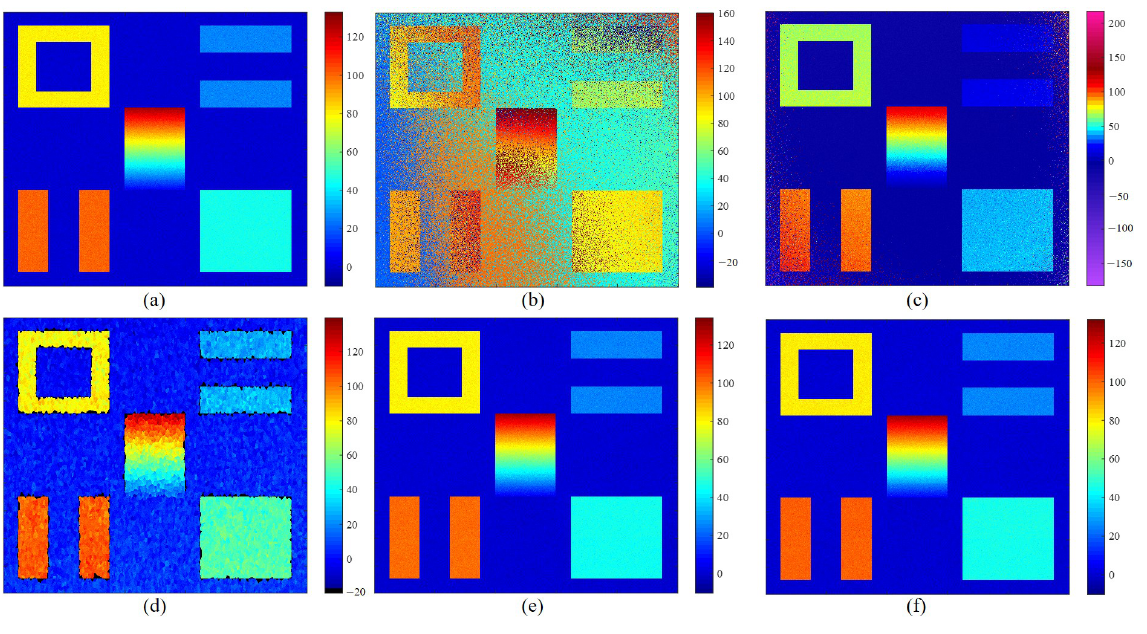
Figure 5. Comparison of elevation estimated results of the simulated test area: ( a ) PEs free data; ( b ) the data with PEs; the data after PE compensation by using the ( c ) PGA, ( d ) TTNC, ( e ) NC-PGA and ( f ) BBN-PGA methods.